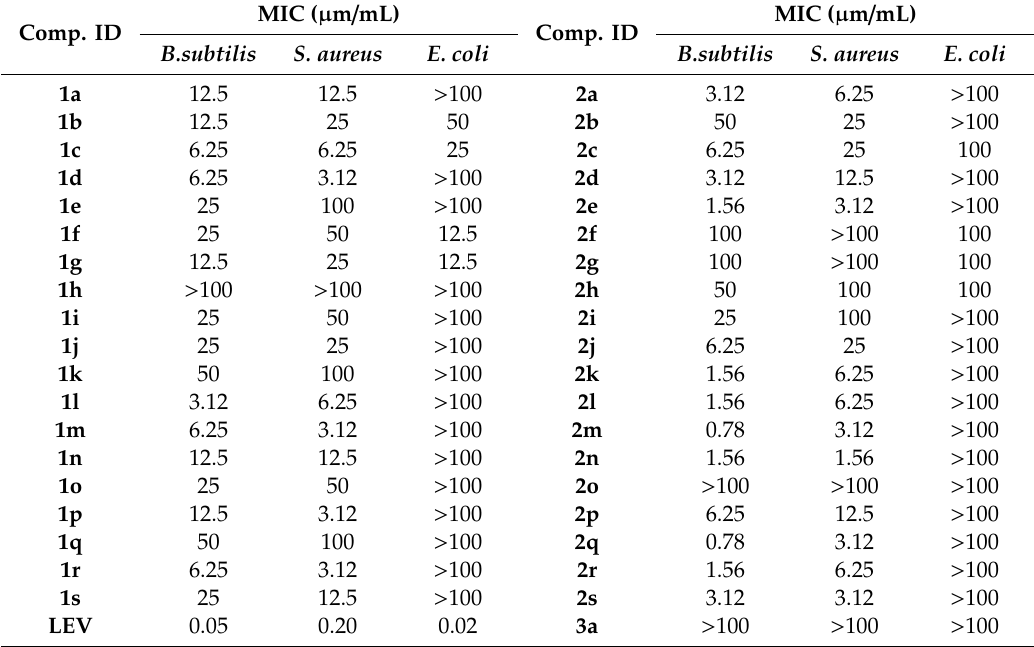
Table 3. The antibiotic activity of compounds 1a – 1s and 2a –